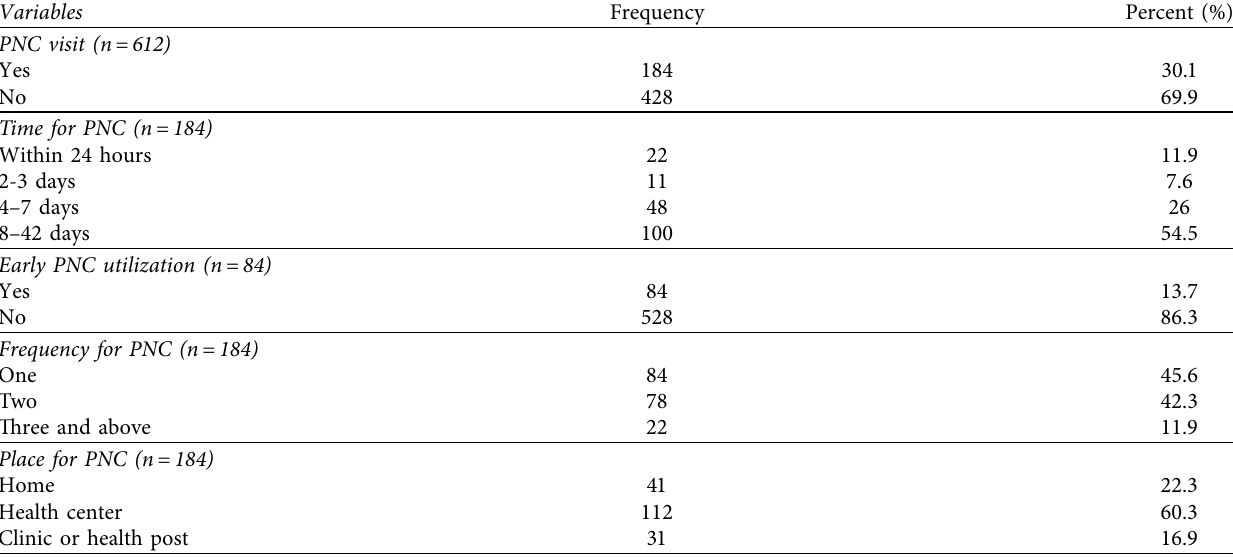
Table 3: Utilization of early postnatal care service among mothers who gave birth in the last six months at Wonago District, South Ethiopia, 2017.